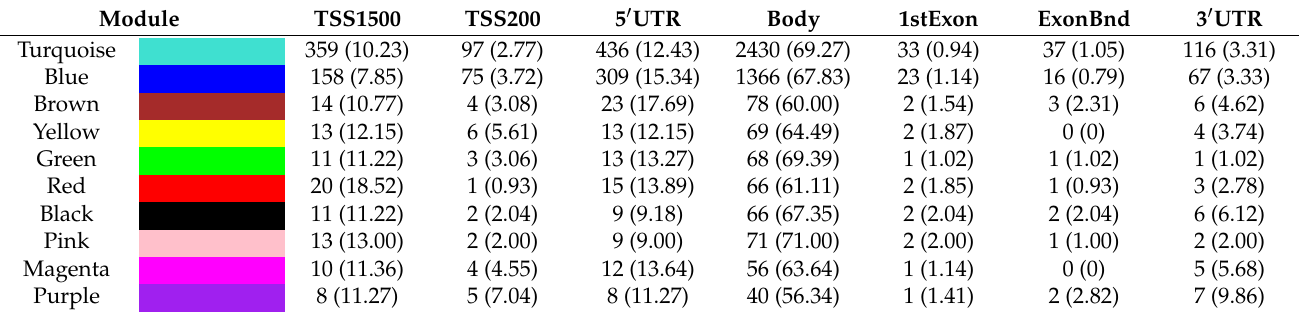
Table 2. Comethylation module CpG sites classification.